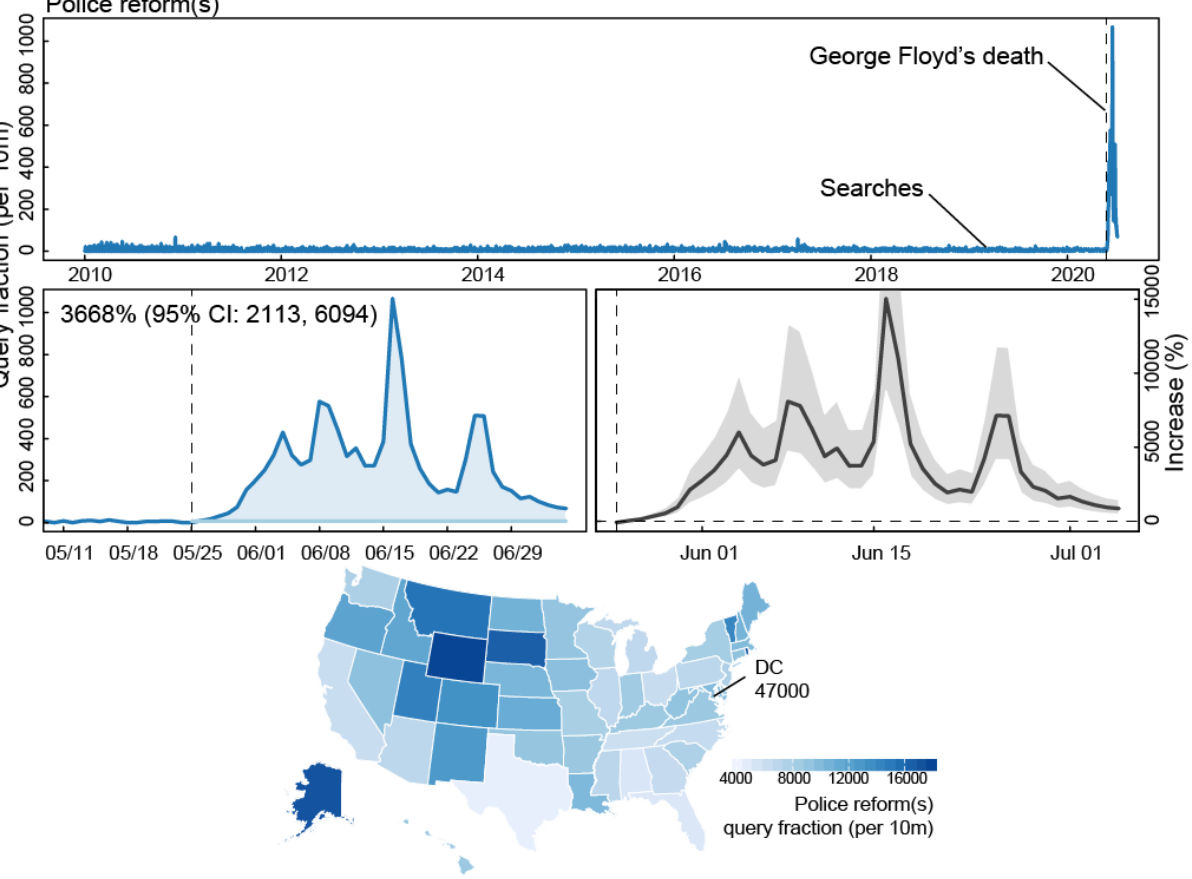
Figure 1. Internet searches for “police” and “reform(s)” following the death of George Floyd. Queries included all searches with the terms “police” and “reform(s).” Top panel shows the historic trends of reform searches in comparison to after Mr Floyd’s death. Middle panels show the percent increases in searches after Mr Floyd’s death (vertical dashed line is the day of the killing, May 25, 2020), and the bottom map shows the cumulative query fraction by state, including Washington DC, for the entire period following Mr Floyd’s death (May 25, 2020, through July 5,